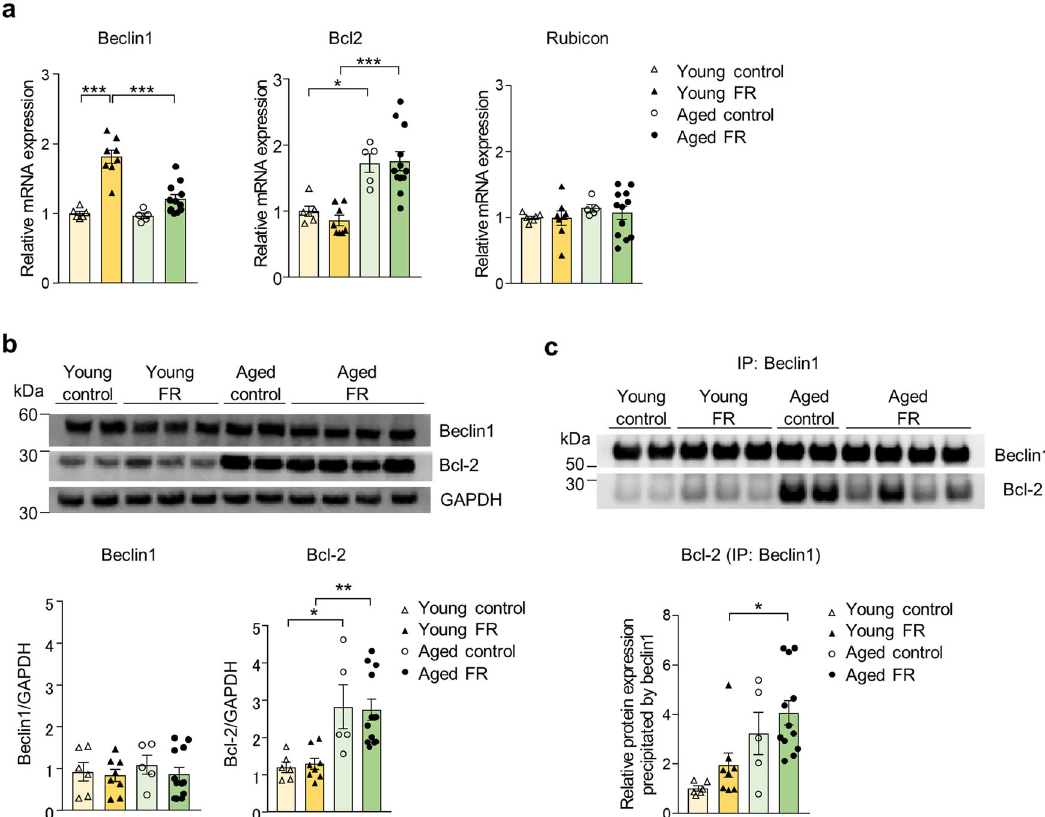
Fig. 7 Interaction between Beclin 1 and Bcl-2 on day 5 of food restriction. a Relative mRNA expression levels of autophagy-related peptides in the liver. Protein expression levels of beclin1 and Bcl-2 in the liver with representative ( b ) western blot images and c co- immunoprecipitation analysis. The shown blots were cropped to improve the conciseness and the full-length blots are presented in Supplementary Fig. 5. * P < 0.05, ** P < 0.01, *** P < 0.001 by Tukey test: young control ( n = 6), young food-restricted (FR) ( n = 8), aged control ( n = 5), and aged FR ( n = 12). Data are presented as mean ±